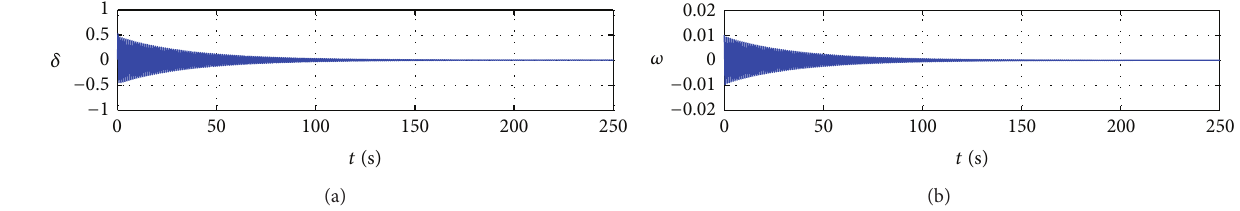
Figure 8: Time waveforms of 𝛿 and 𝜔 with 𝐾 𝑖 = 1 , 𝐾 𝑝 = 2 , and 𝐾 𝑑 = 1.15 .